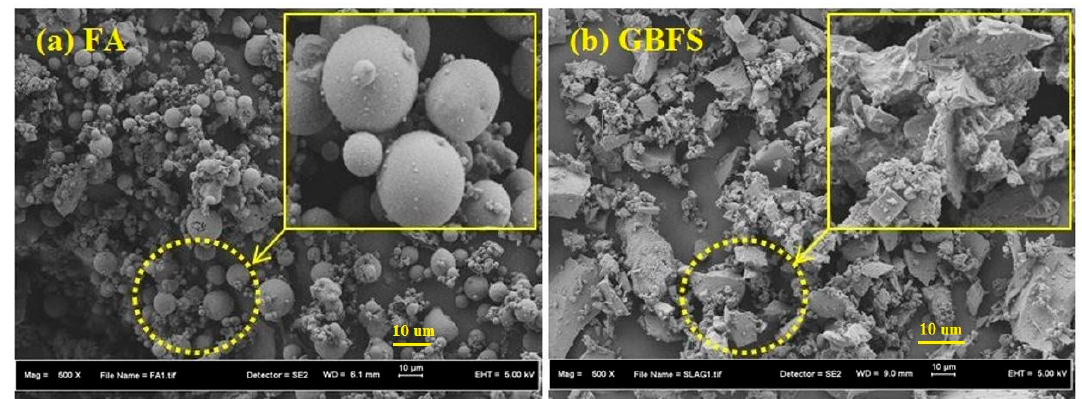
Figure 1. SEM images of ( a ) FA and ( b ) GBFS.